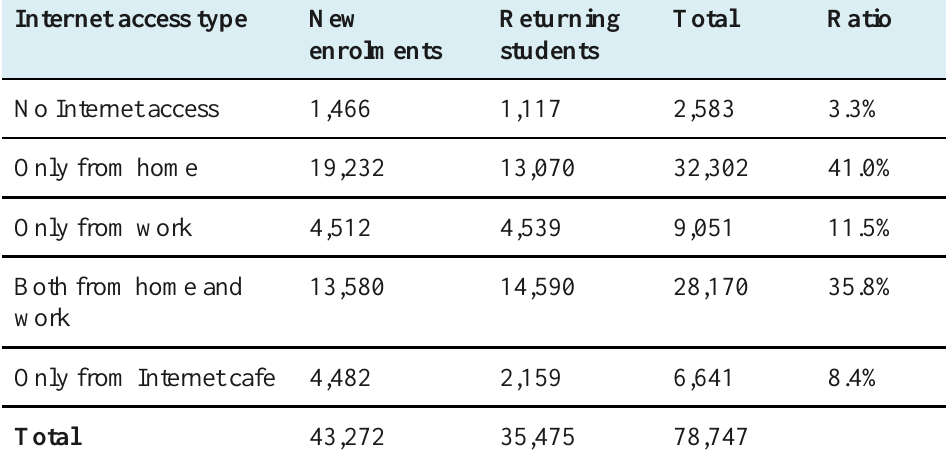
Internet access types and ratios